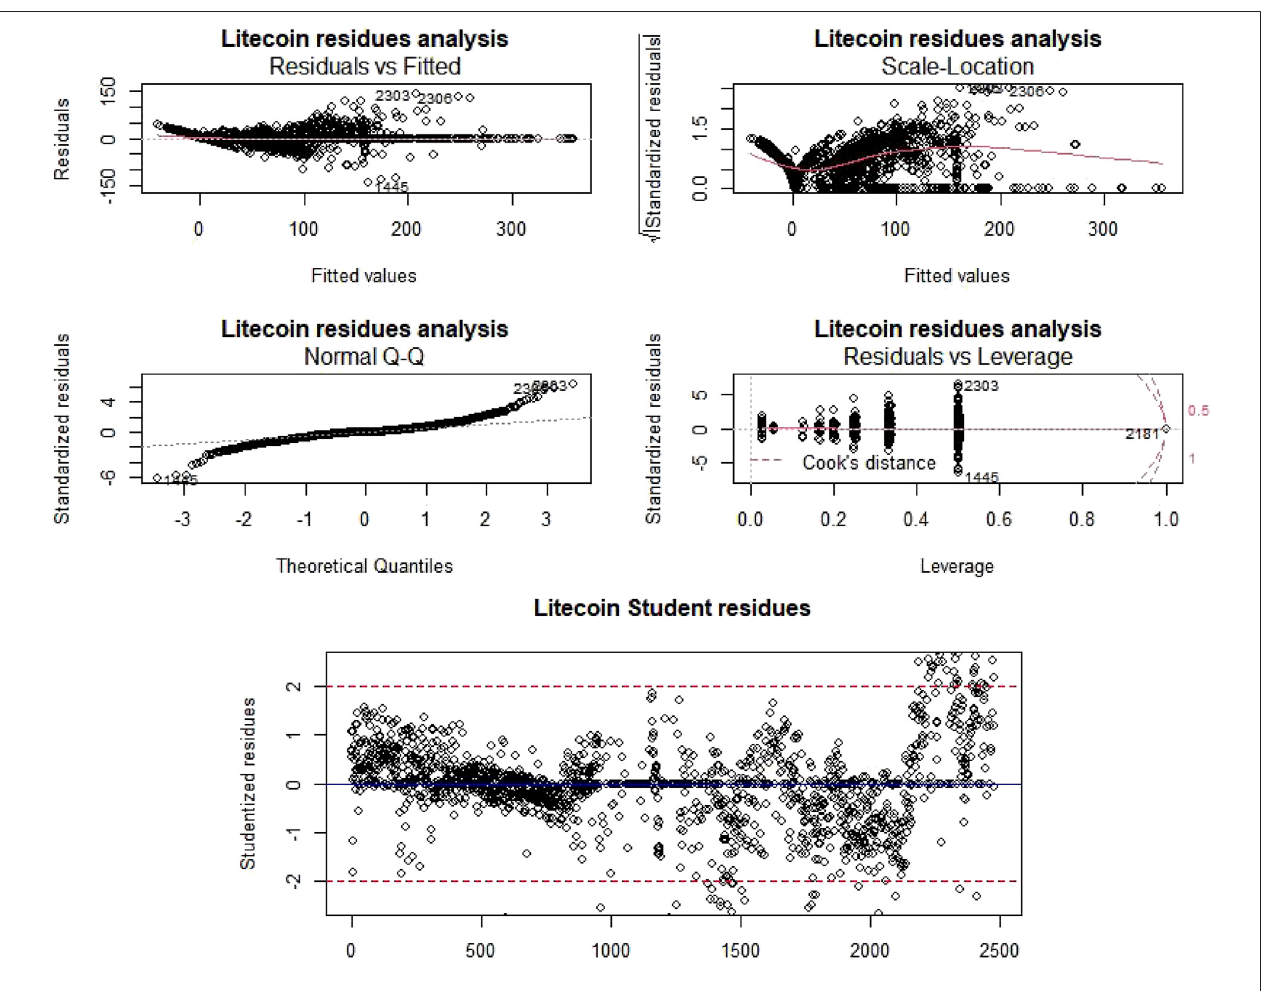
FIGURE 8 | Litecoin residue analysis and outlier detection.